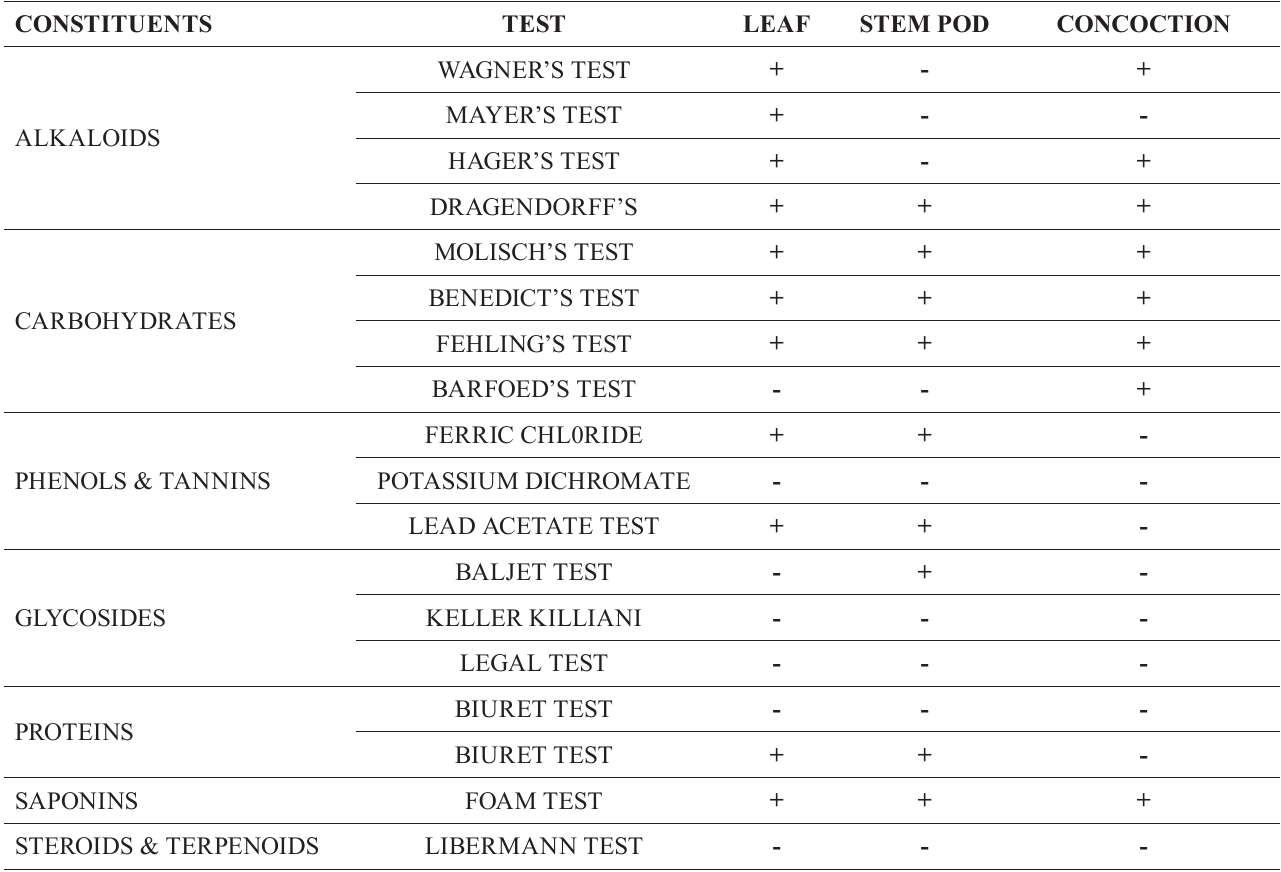
TABLE I - P hytochemical screening of extracts of Basella rubra CONSTITUENTS